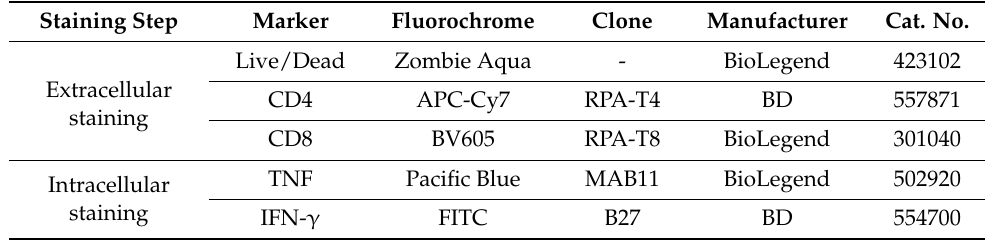
Table 2. Monoclonal antibody panel for